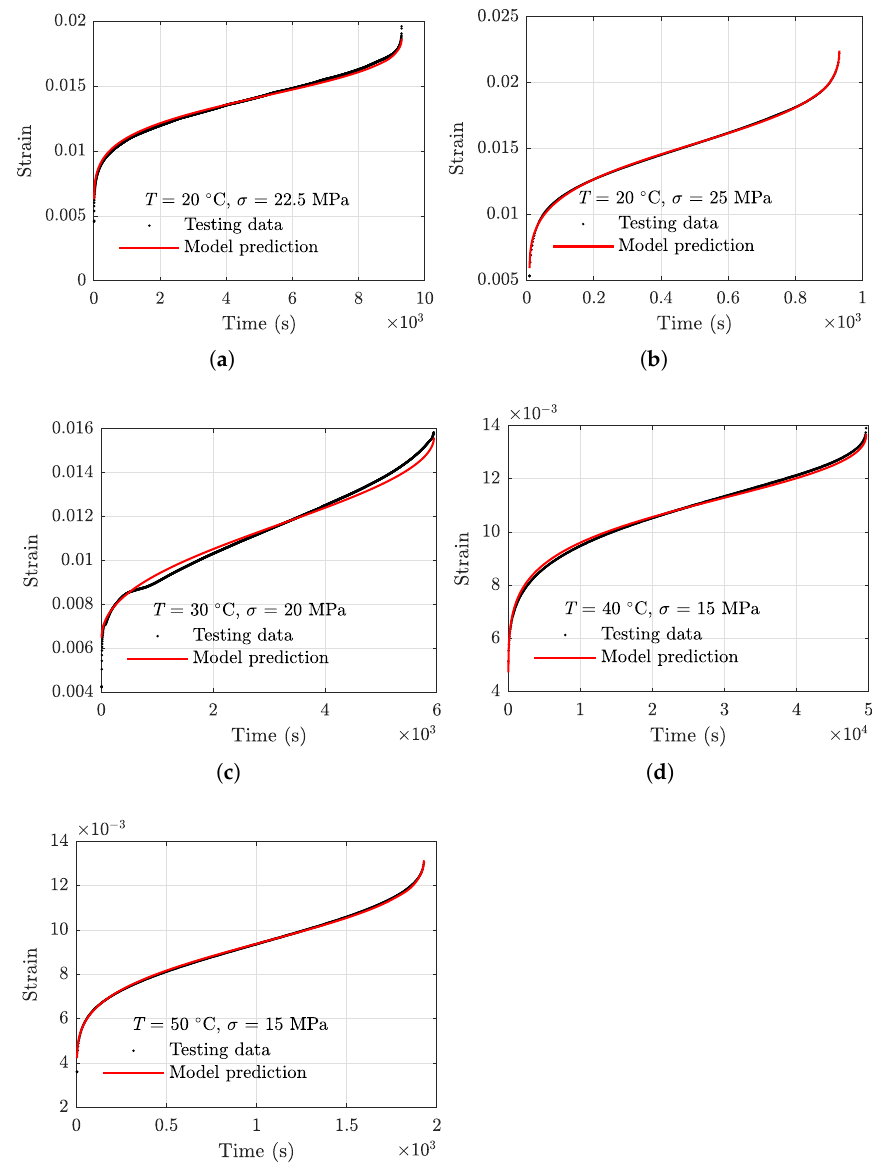
Figure 8. Results of creep strain prediction using Equation (7) with parameters in Table 2. ( a ) 20 ◦ C, 22.5 MPa, ( b ) 20 ◦ C, 25 MPa, ( c ) 30 ◦ C, 20 MPa, ( d ) 40 ◦ C, 15 MPa, and ( e ) 50 ◦ C, 15